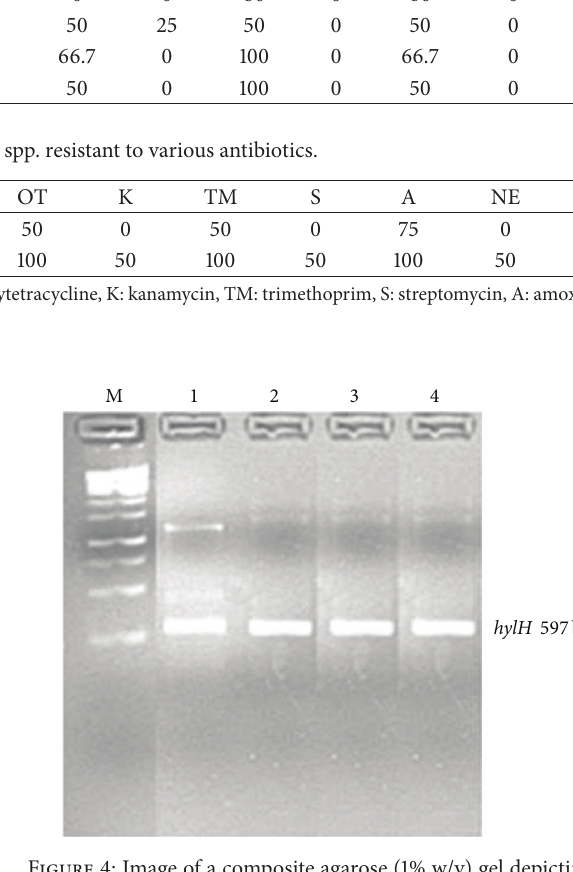
Figure 4: Image of a composite agarose (1% w/v) gel depicting the hylH gene from Aeromonas species. Lane M (1kb DNA Ladder); Lanes 1–4 ( hylH gene fragments from Aeromonas species